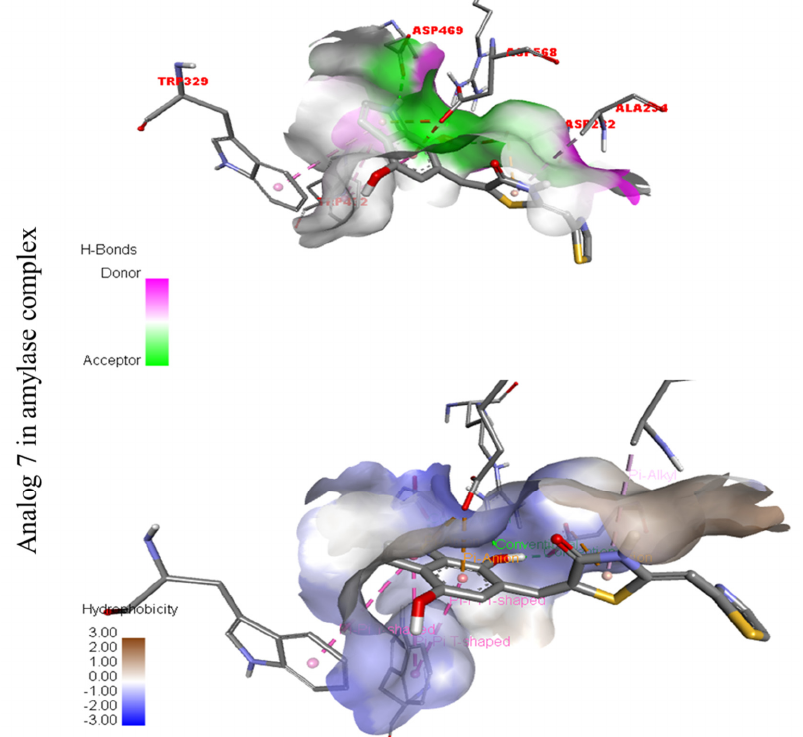
Figure 13. Represent hydrogen bond and hydrophobic character against Alpha-amylase indicate the PLI profile for compound 7 .